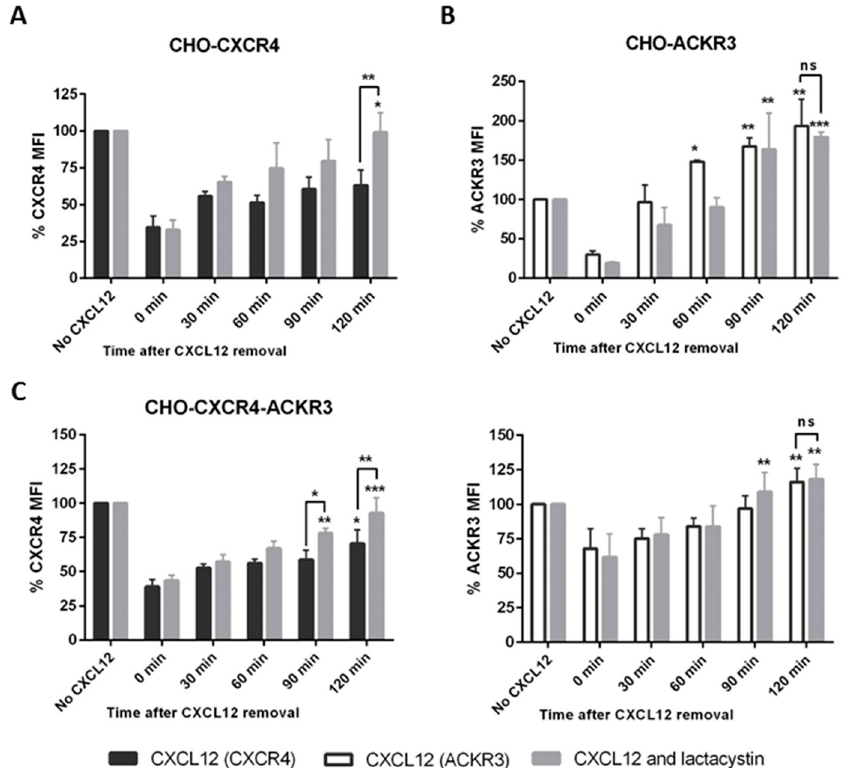
Figure 5. Preventing receptor degradation after CXCL12 stimulation using lactacystin, a proteasome inhibitor. ( A ) CHO-CXCR4, ( B ) CHO-ACKR3 and ( C ) CHO-CXCR4-ACKR3 cells were pre-treated